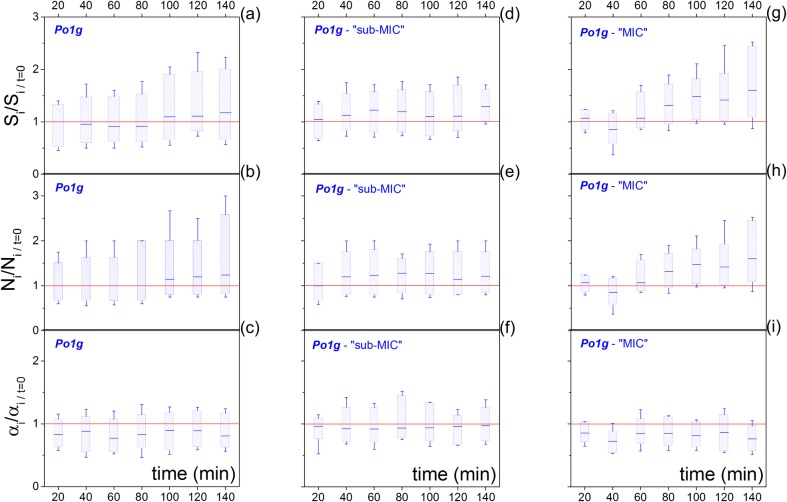
(a-c) Boxcharts of the longitudinal fluctuations of the lipid content (Si−a), number of LDs (Ni−b) and median LD size (αi−c). The boxcharts represent the median, 25% - 75% range, and the whiskers the 20% - 80% range. All single-cell observations are normalized to initial value at t = 0 for each cell-lineage. (d-f) and (g-i) illustrate the same longitudinal traces for the sub-MIC (d-f) and for the MIC (g-i) concentration of CHX.